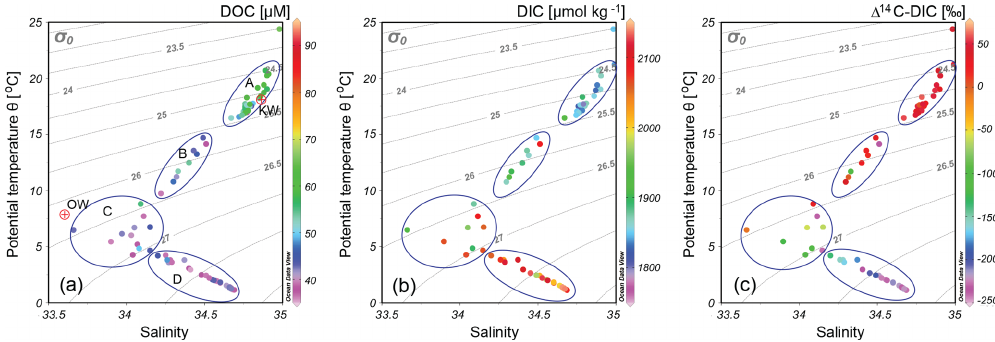
Figure 8. Plot of potential temperature ( θ ) vs. salinity with (a) DOC concentrations, (b) DIC concentrations and (c) (cid:49) 14 C-DIC values (indicated as the colours of points) associated with the potential water density ( σ t ) for eight stations in the northwestern North Pacific. The circular areas represent different water masses in terms of (A) lower-density water in the upper 300m depth; (B) mixed upper water in 300– 500m depth; (C) mixed intermediated water in 500–800m water depth; and (D) denser North Pacific deep water below 1000m depth. Higher levels of DOC were associated with lower DIC concentrations, and high (cid:49) 14 C-DIC values were found in lower-density waters ( σ 0 <25.5, water mass A), while lower levels of DOC were associated with higher DIC concentrations, and low (cid:49) 14 C-DIC values occurred in denser waters (water mass C at 26.4–27.1 σ 0 and water mass D at σ 0 >27.1). Note: DOC concentrations were measured for all stations, whereas DIC results from Ding et al. (2018) were only measured for six stations except stations A1-b and A6. Red dots indicate the potential temperature and salinity of the water types, and acronyms of water types as in Fig. 4 are